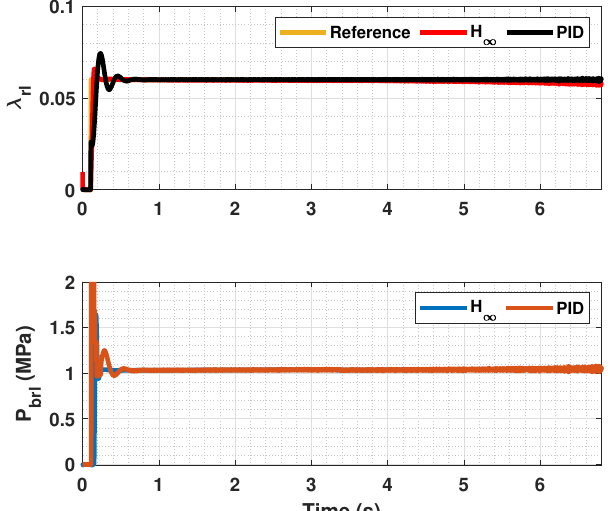
Figure 12. Rear wheels tire slip, reference tire slip and brake pressure for µ max = 0.20.